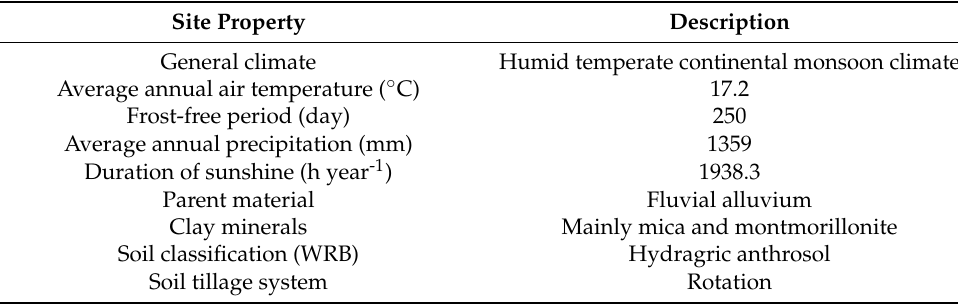
Table 2. Environmental description of the study area.